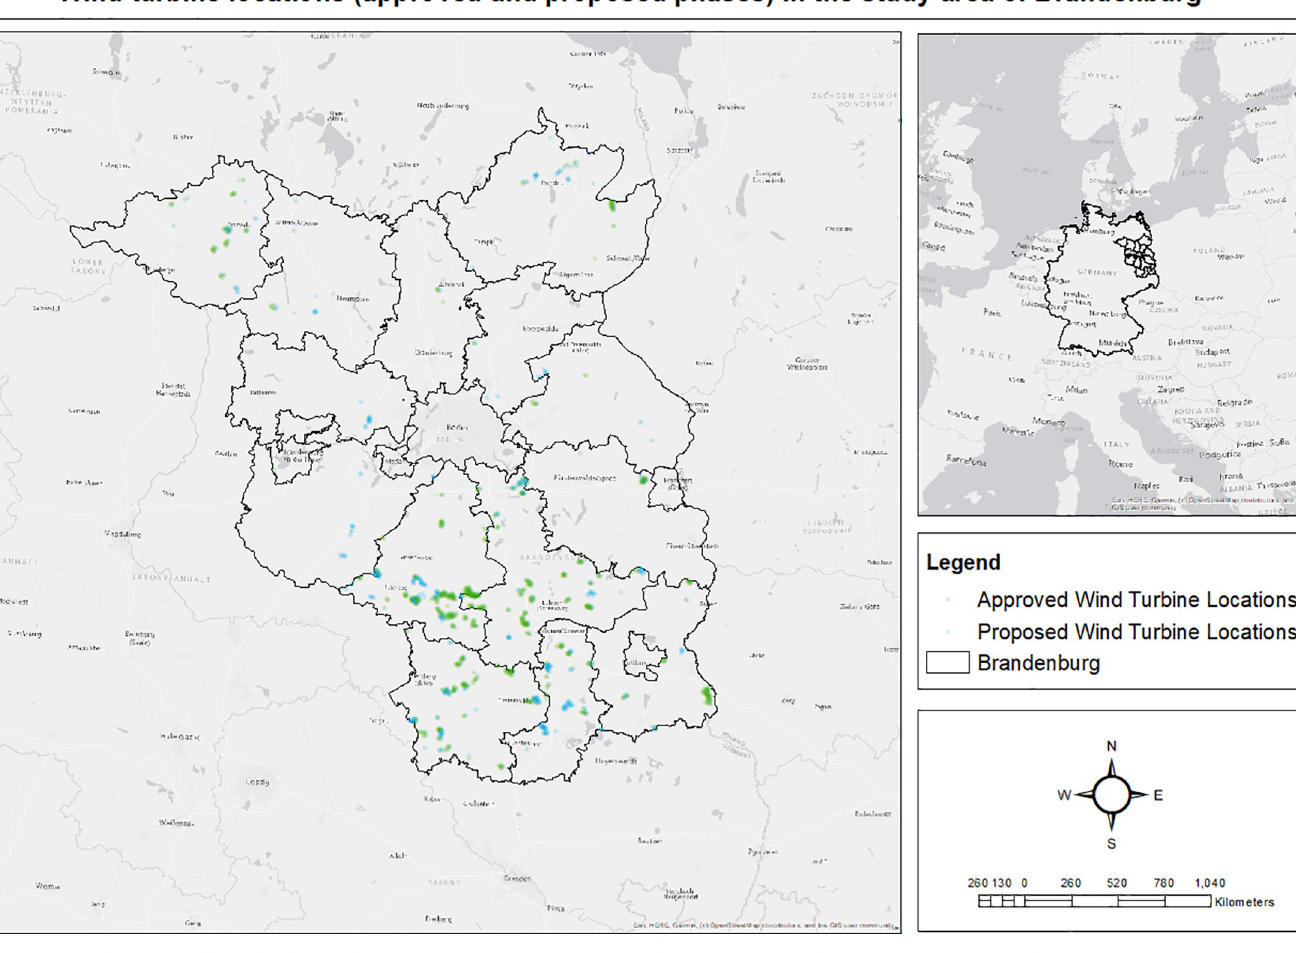
Fig 11. Spatial locations of the to-be deployed wind turbines in their approved and proposed phases of development in Brandenburg, Germany.